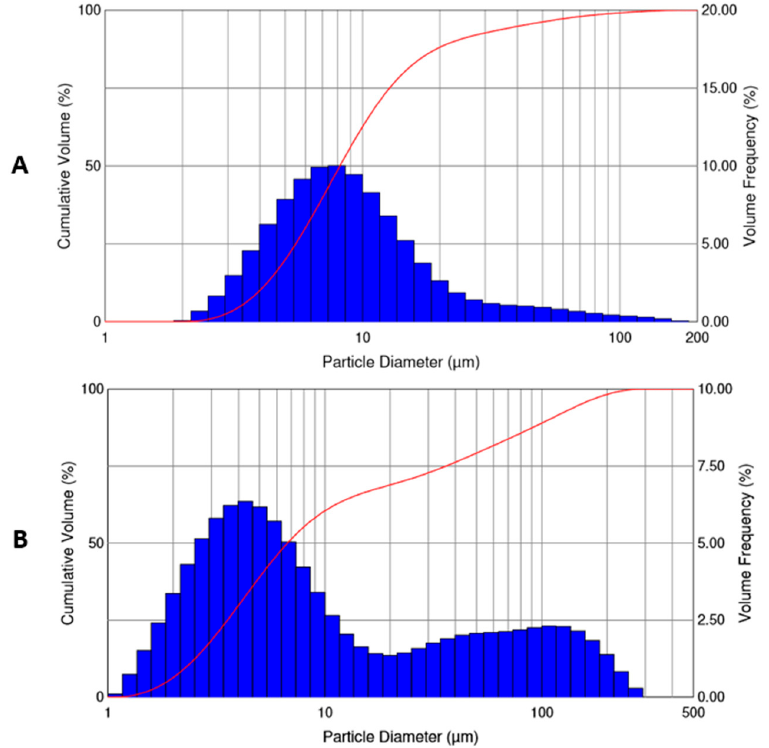
Figure 8. Volume size distribution of particle fraction in powder inhalers, polyDBB_PEG_600_20 microspheres, obtained by using homogenization speed of 9000 rpm ( A ) and 18,000 rpm ( B ).